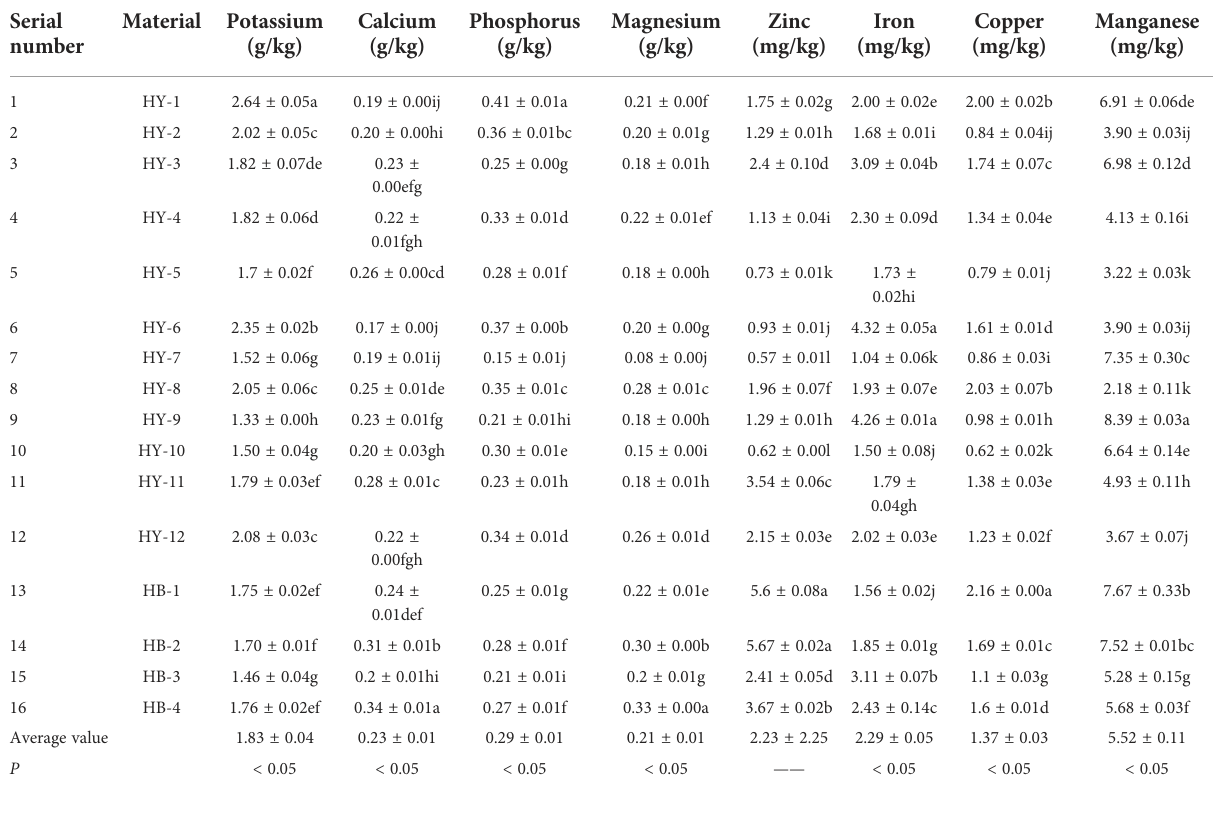
TABLE 8 The content of minerals in the pulp of different genotypes of A. trifoliata fruit.